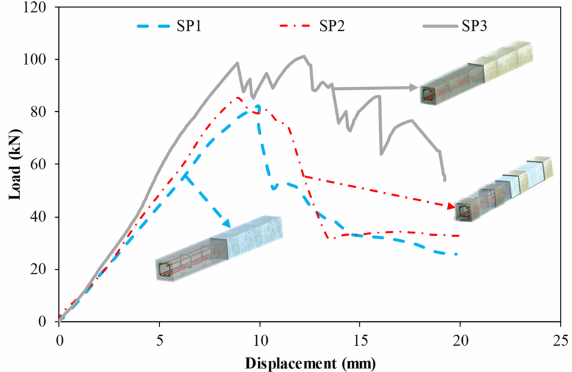
Figure 7. Comparison of Specimens SP1, SP2 and SP3.